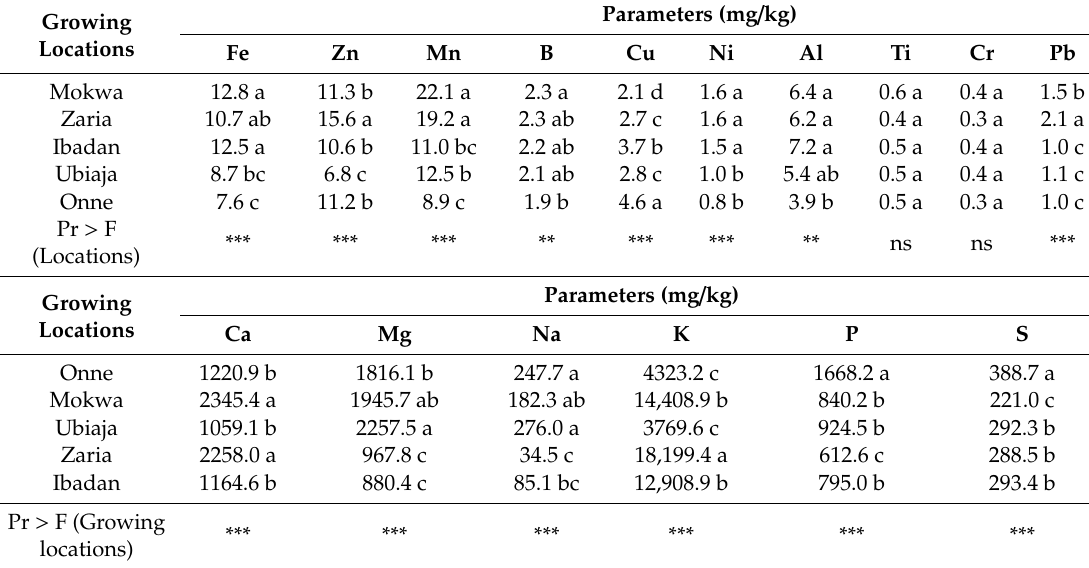
Table 5. Mean value of trace and macro elements of yellow-fleshed cassava roots by growing locations